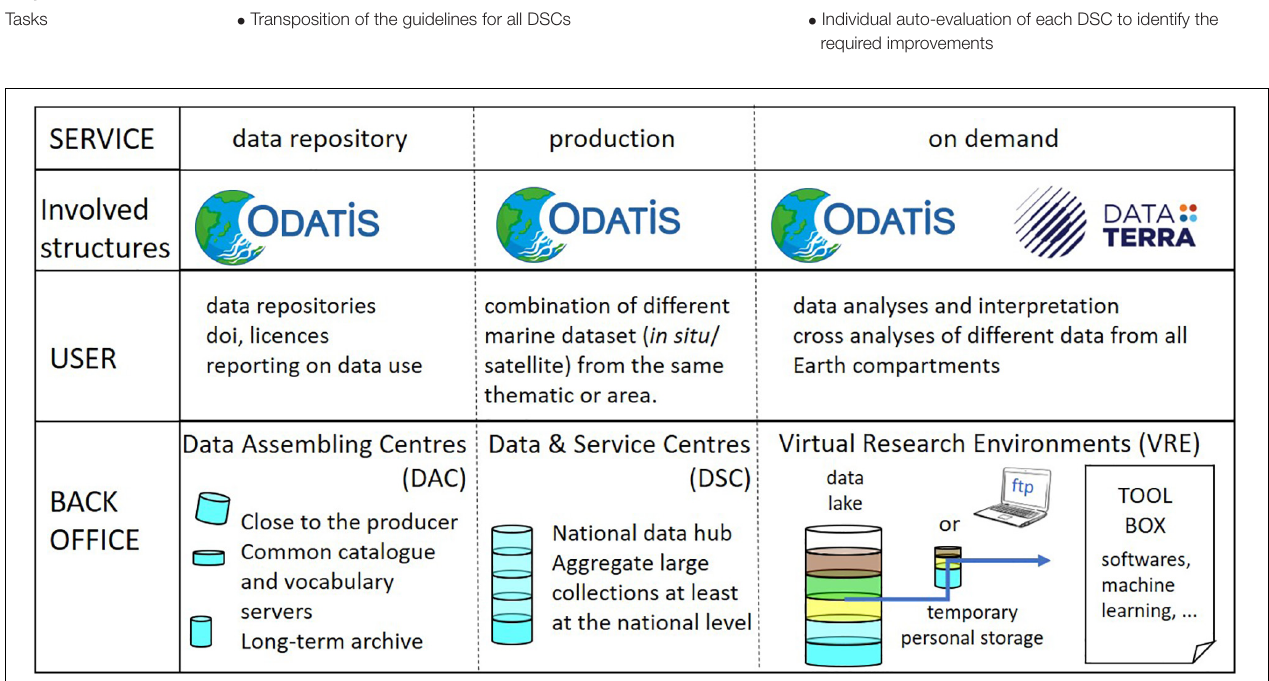
FIGURE 3 | Schematized typologies of data centers, from marine data assembling centers (DAC) and data and services centers (DCS) to the virtual research environment (VRE), in response to user needs. The structure indicates the implication in the management of the data center of ODATIS and its support research infrastructure Data